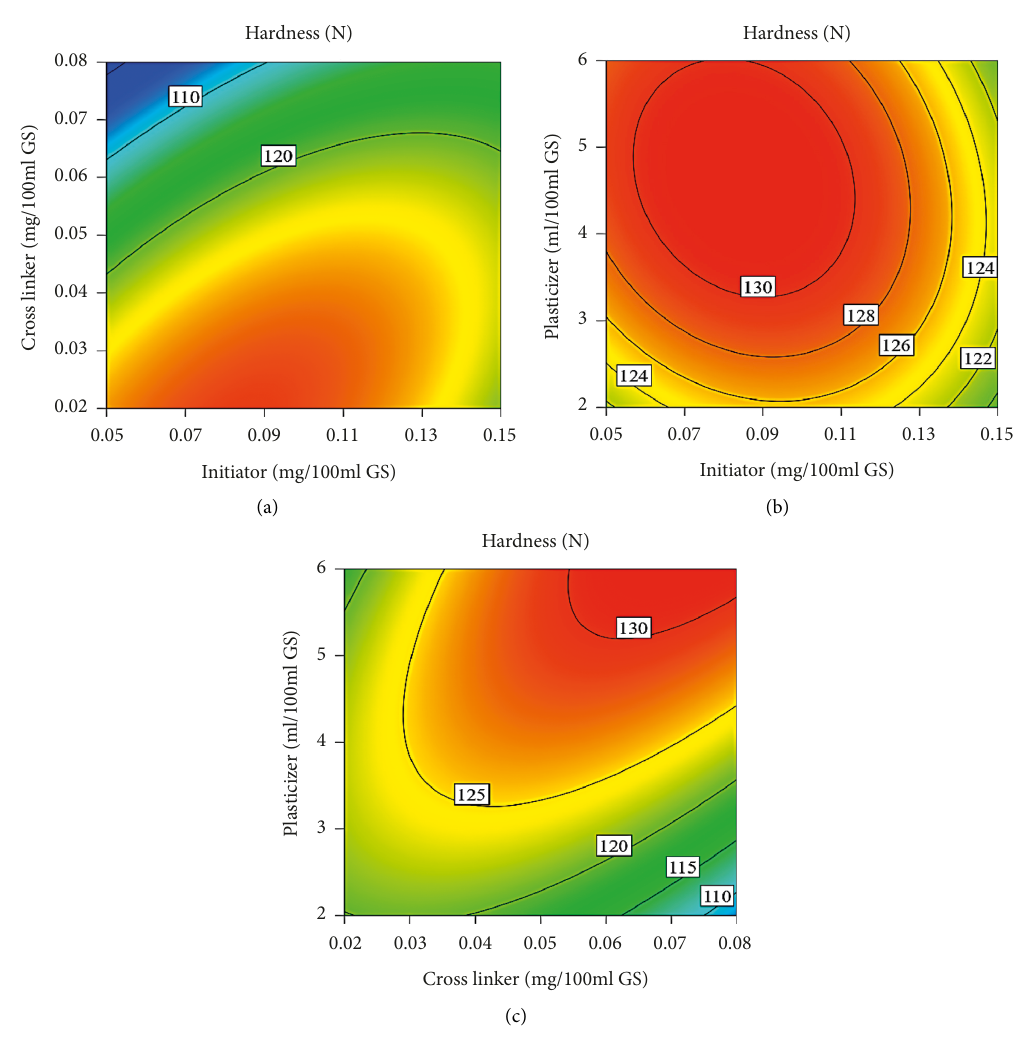
Figure 3: (a) Combined effects of initiator and crosslinker on hardness at the optimum value of plasticizer concentration (2.88 mL/100mL GS). (b) Combined effects of initiator and plasticizer concentration on hardness at the optimum value of crosslinker (0.02mg/100mL GS). (c) Combined effects of crosslinker and plasticizer concentration on hardness at the optimum value of initiator (0.15mg/100mL